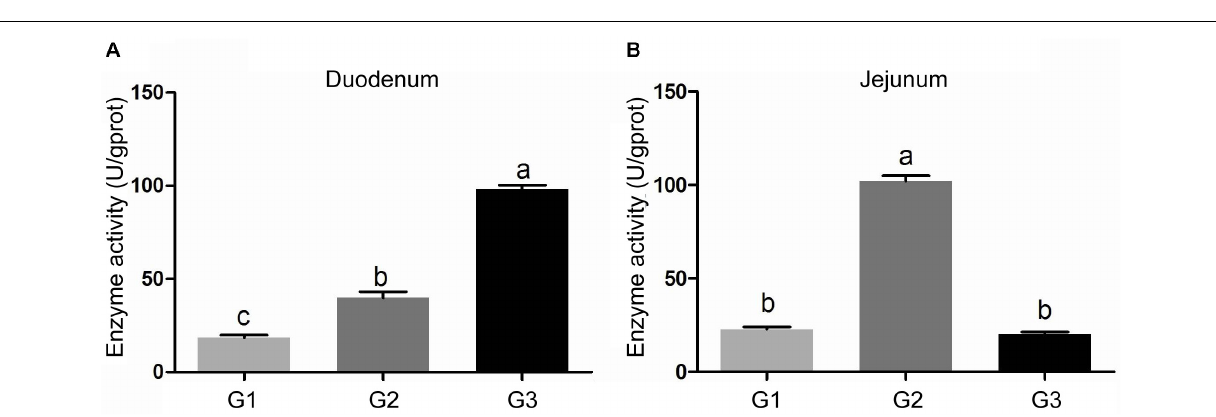
FIGURE 2 | Effects of Ba on amylase activity in contents of duodenum (A) , jejunum (B) , and ileum (C) . Results were expressed as mean ± SEM, n = 6. a and b means significantly different ( p < 0.05).